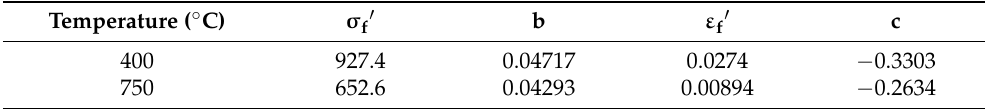
Figure 6. Relationship between the low-cycle fatigue life and strain amplitude of the TiAl alloy ( a ) and the life prediction results by the Manson–Coffin model ( b ). Table 2. Material constants of the Manson–Coffin